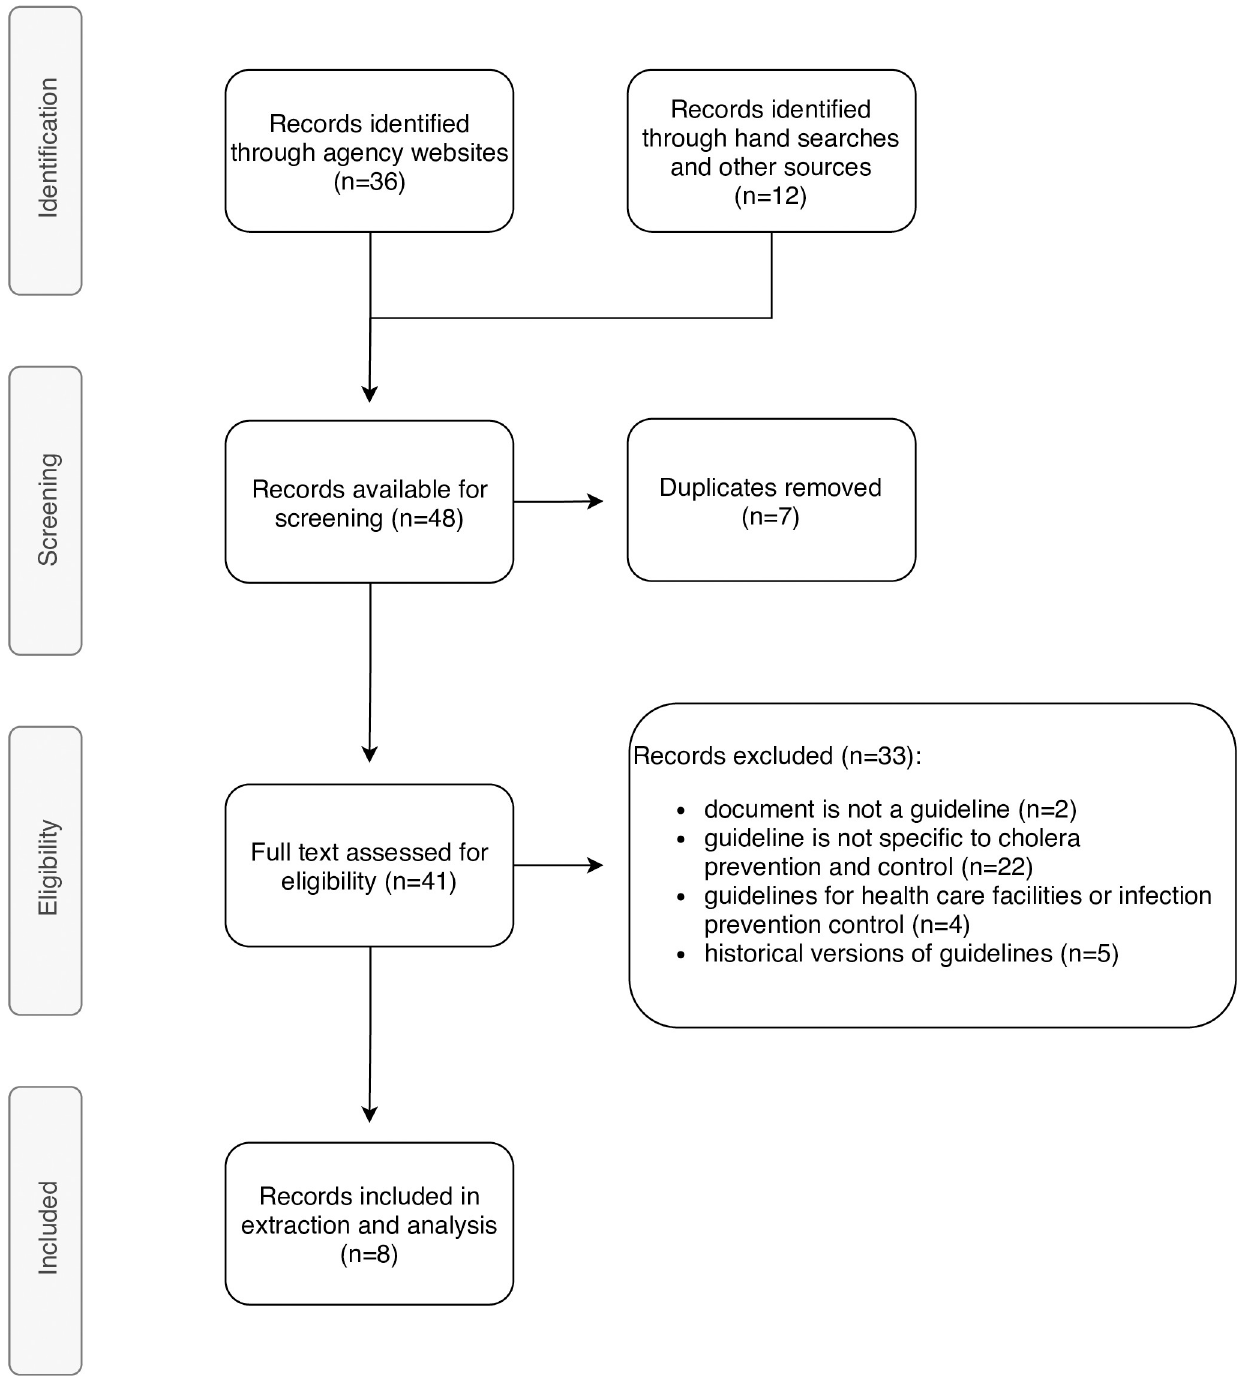
Fig 2. Overview of the search strategy and selection: PRISMA-ScR